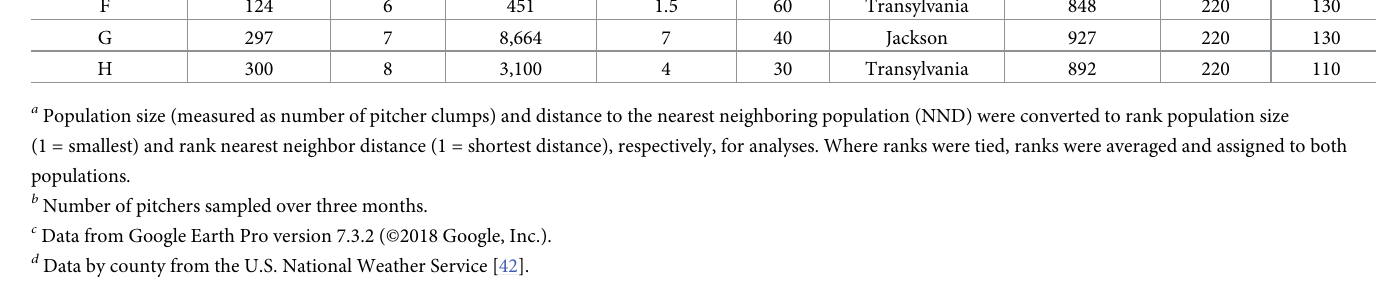
a Population size (measured as number of pitcher clumps) and distance to the nearest neighboring population (NND) were converted to rank population size (1 = smallest) and rank nearest neighbor distance (1 = shortest distance), respectively, for analyses. Where ranks were tied, ranks were averaged and assigned to both populations. b Number of pitchers sampled over three